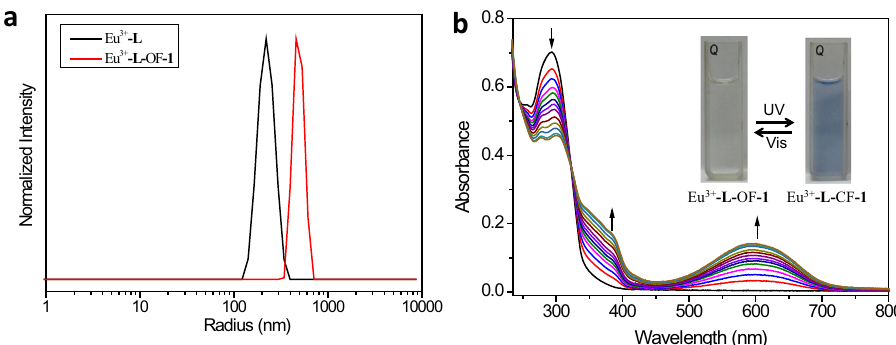
Fig. 3 DLS size distribution and UV – Vis spectral studies. a DLS size distribution of Eu 3 + - L (black curve) and Eu 3 + - L -OF- 1 (red curve) ([Eu 3 + ] = 1.4 × 10 − 4 M, [ L ] = [OF- 1 ] = 2.1 × 10 -4 M). b UV – Vis spectral changes and corresponding photographic images of Eu 3 + - L -OF- 1 and Eu 3 + - L -CF- 1 with alternating 300nm UV and >450nm visible light irradiation in water for up to 60s each time ([Eu 3 + ] = 1.4 × 10 -5 M, [ L ] = [OF - 1 ] = 2.1 × 10 − 5